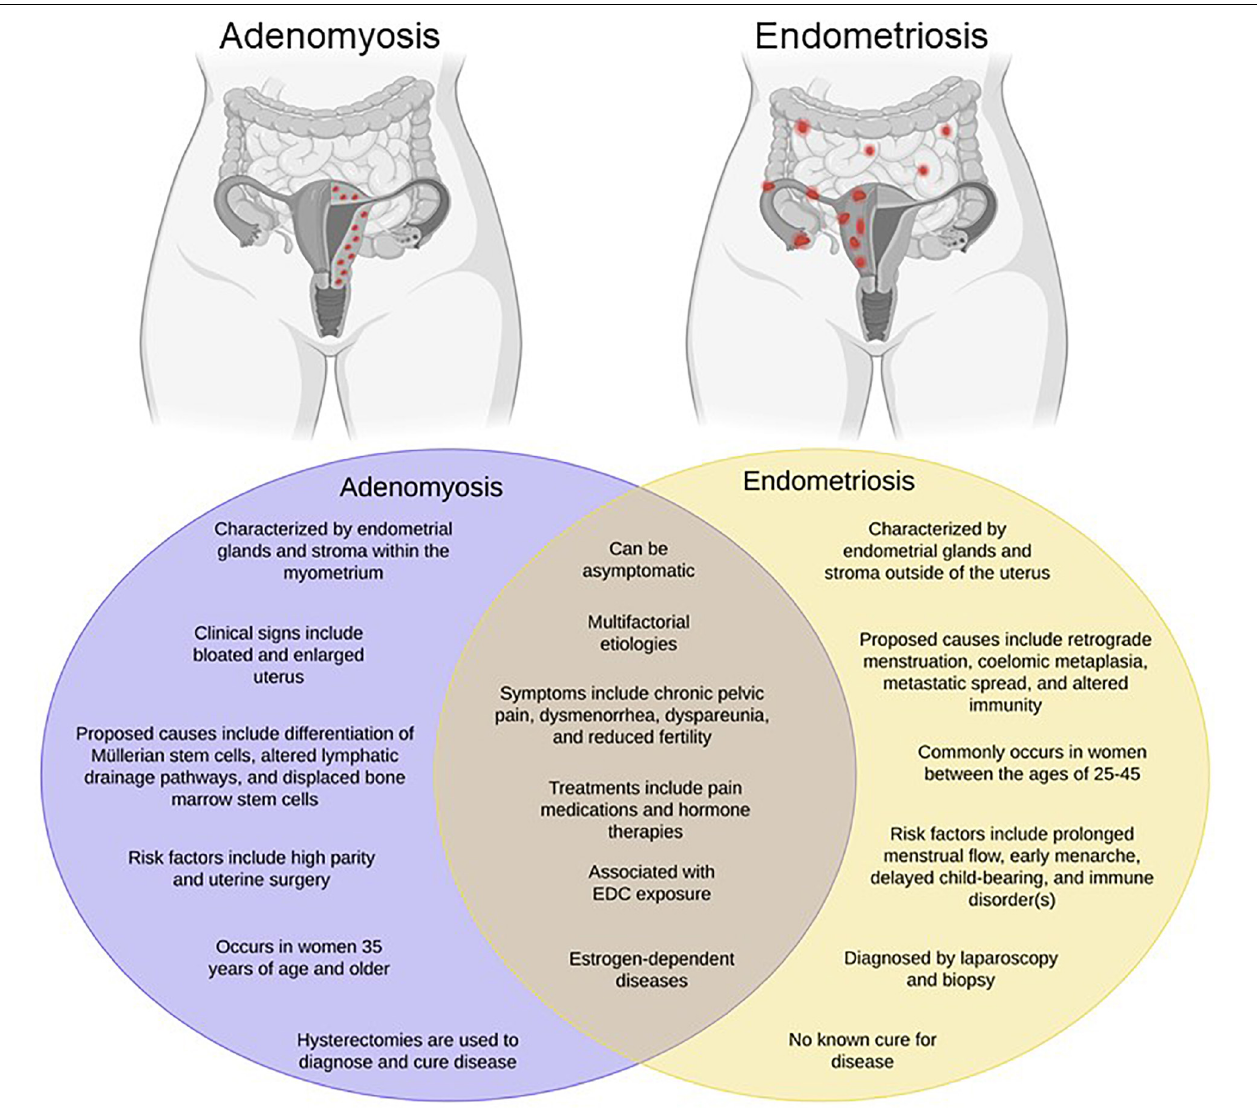
FIGURE 1 | Endometriosis and adenomyosis exhibit overlapping phenotypes. Adenomyosis has been referred to as “endometriosis interna” due to its resemblance to endometriosis both histologically and phenotypically. However, as shown in the Venn diagram, while the diseases have many common features, they also exhibit a number of differences. Created with